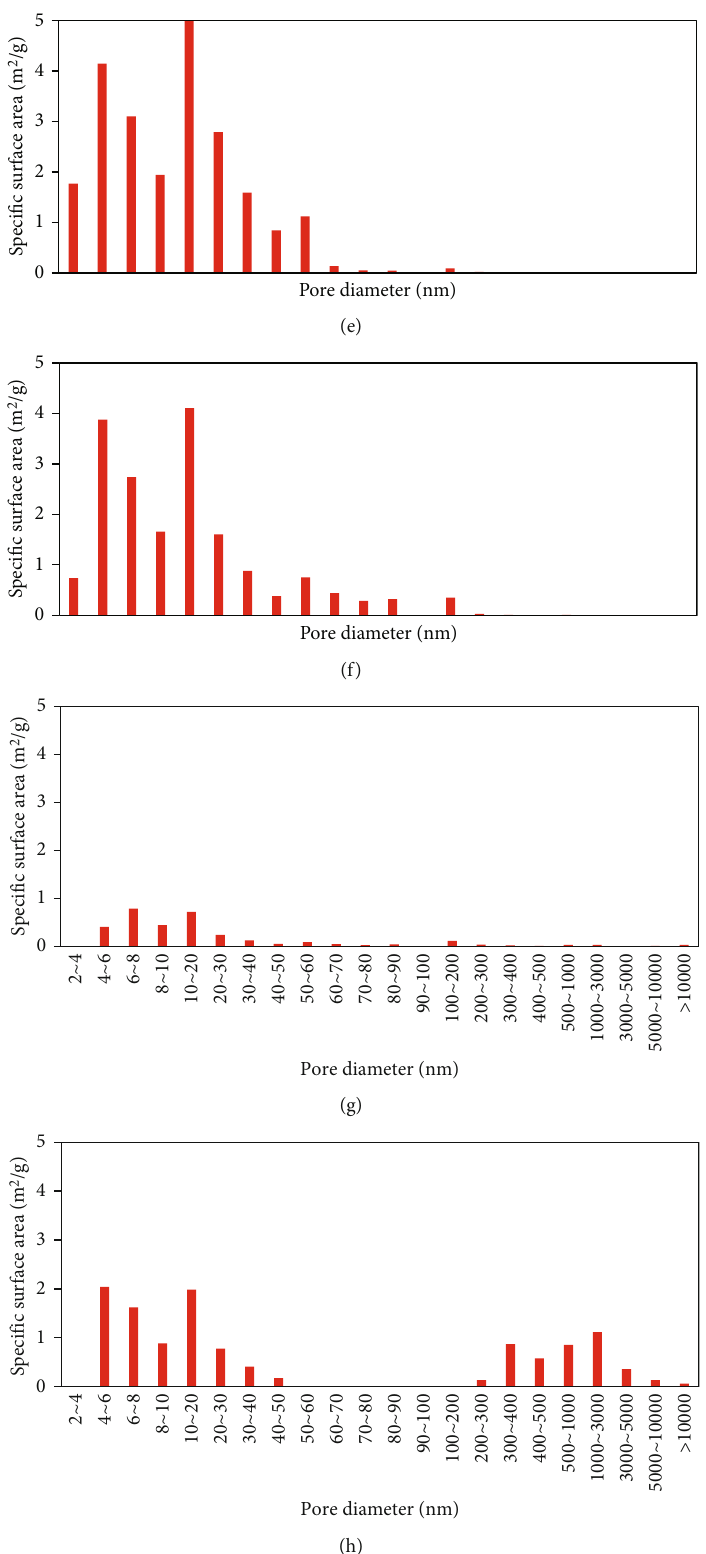
Figure 11: The speci fi c surface area distribution of mudstone in the Qigequan Formation. (a) H-1: pure mudstone; (b) H-2: pure mudstone; (c) H-3: pure mudstone; (d) H-4: silty mudstone; (e) H-5: silty mudstone; (f) H-6: silty mudstone; (g) H-7: sandy mudstone; (h) H-2: sandy